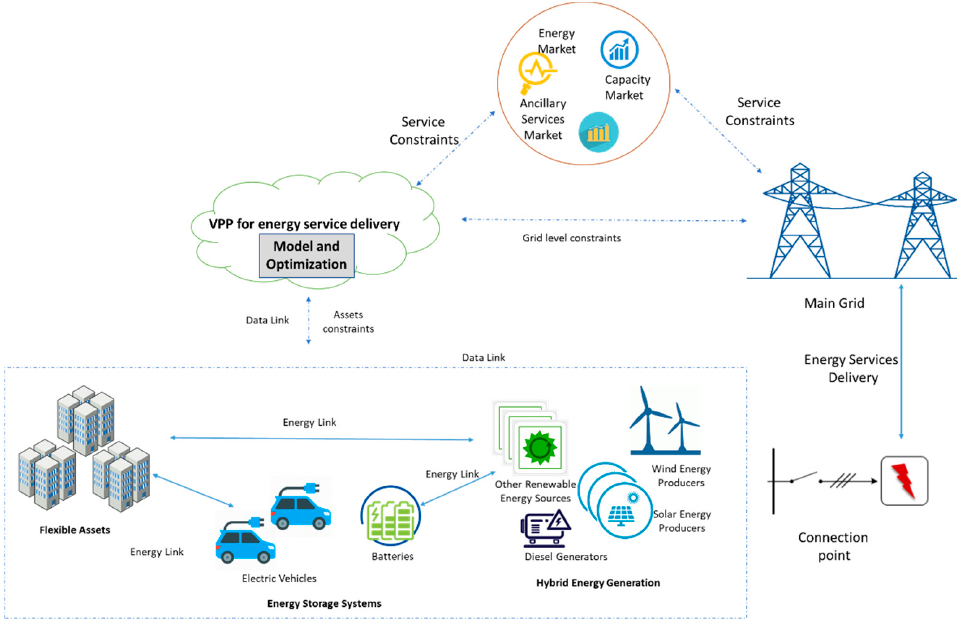
Figure 4. VPP coordination for energy service delivery.